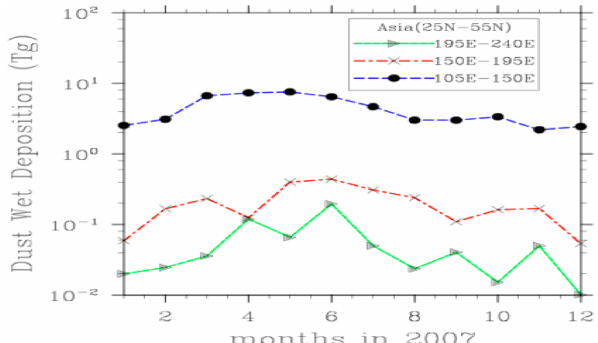
Fig. 7. Map used in this study for Asian dust. The dashed lines de- note the four longitude planes (105 ◦ E, 150 ◦ E, 195 ◦ E, and 240 ◦ E) and the latitude boundary (25 ◦ N to 55 ◦ N). The CALIPSO tracks are shown as lines along the asterisks and cross marks.